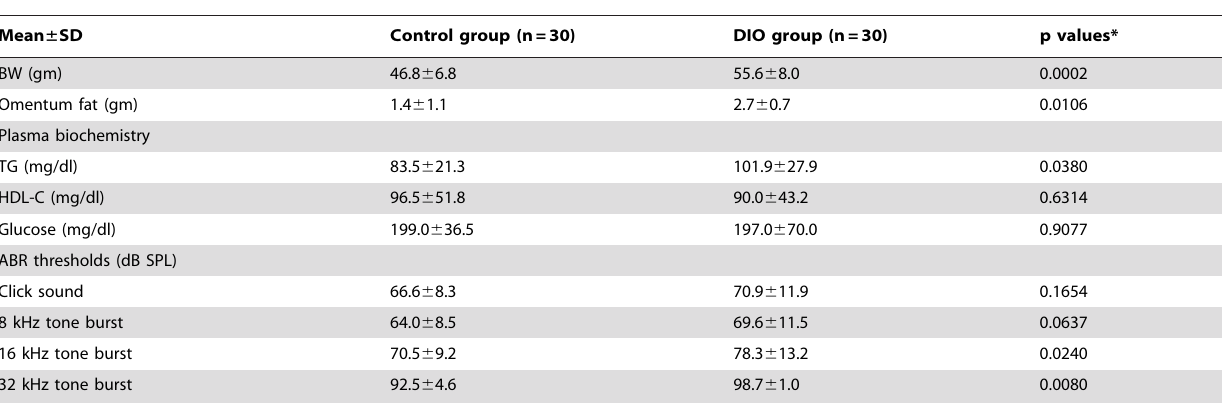
Table 2. Comparisons of the both groups at the end of this